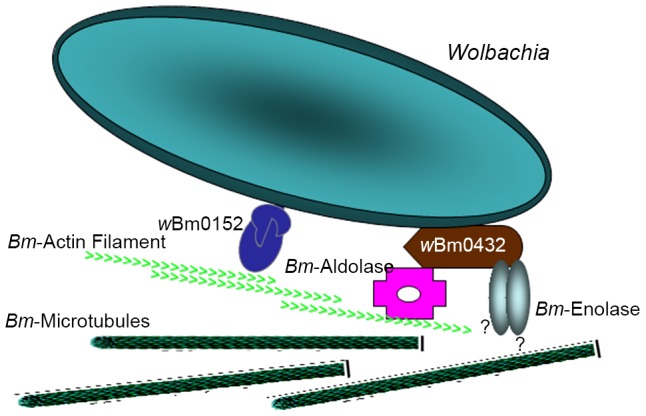
The model for Bm-wBm interactions.The complex of wBm0432 with the GE proteins is potentially associated with the complex of wBm0152/cytoskeletal proteins via aldolase and/or enolase.